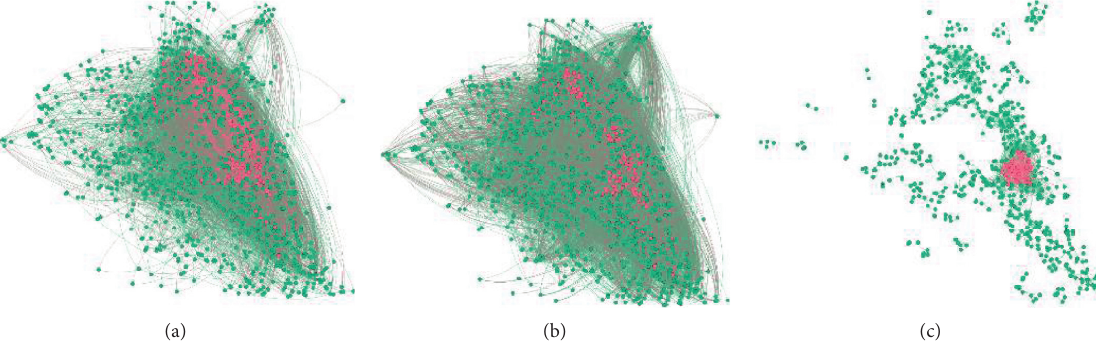
Figure 3: The visualization of the highest core nodes (red dots) and other nodes (green dots) of the networks constructed by the method of (a) TS, (b) TW, and (c) STID.